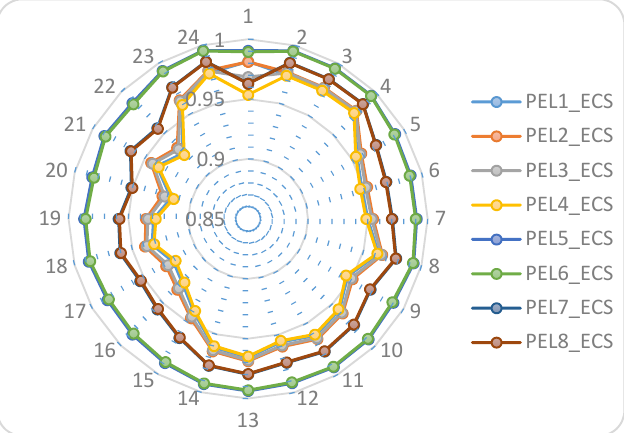
Figure 5. One-hour-ahead PEL nodal prices.